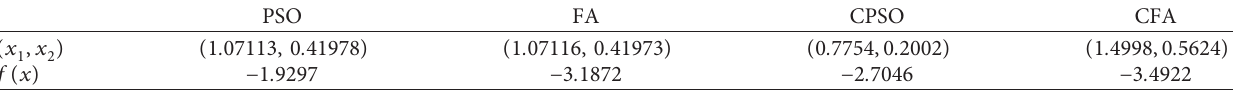
Table 4: The results of problem (2) by using SAs.